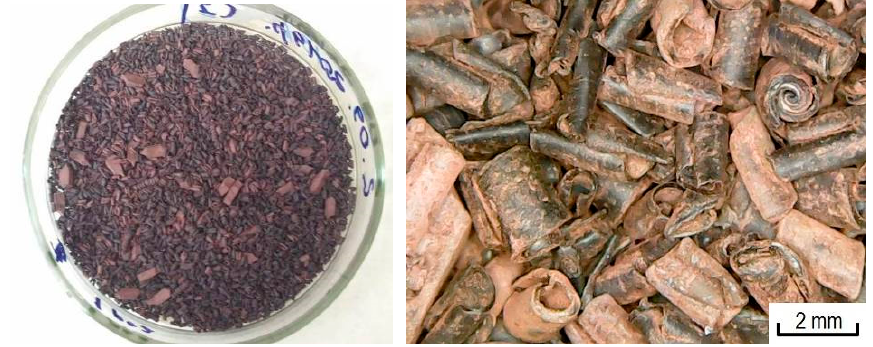
Figure 3. Kinetics of hydrogen release during copper plating of the activated surface of polypropylene waste. Concentration (mmol/L): CuSO 4 -60; EDTA-Na2–67; NaOH-375; formaldehyde 366.